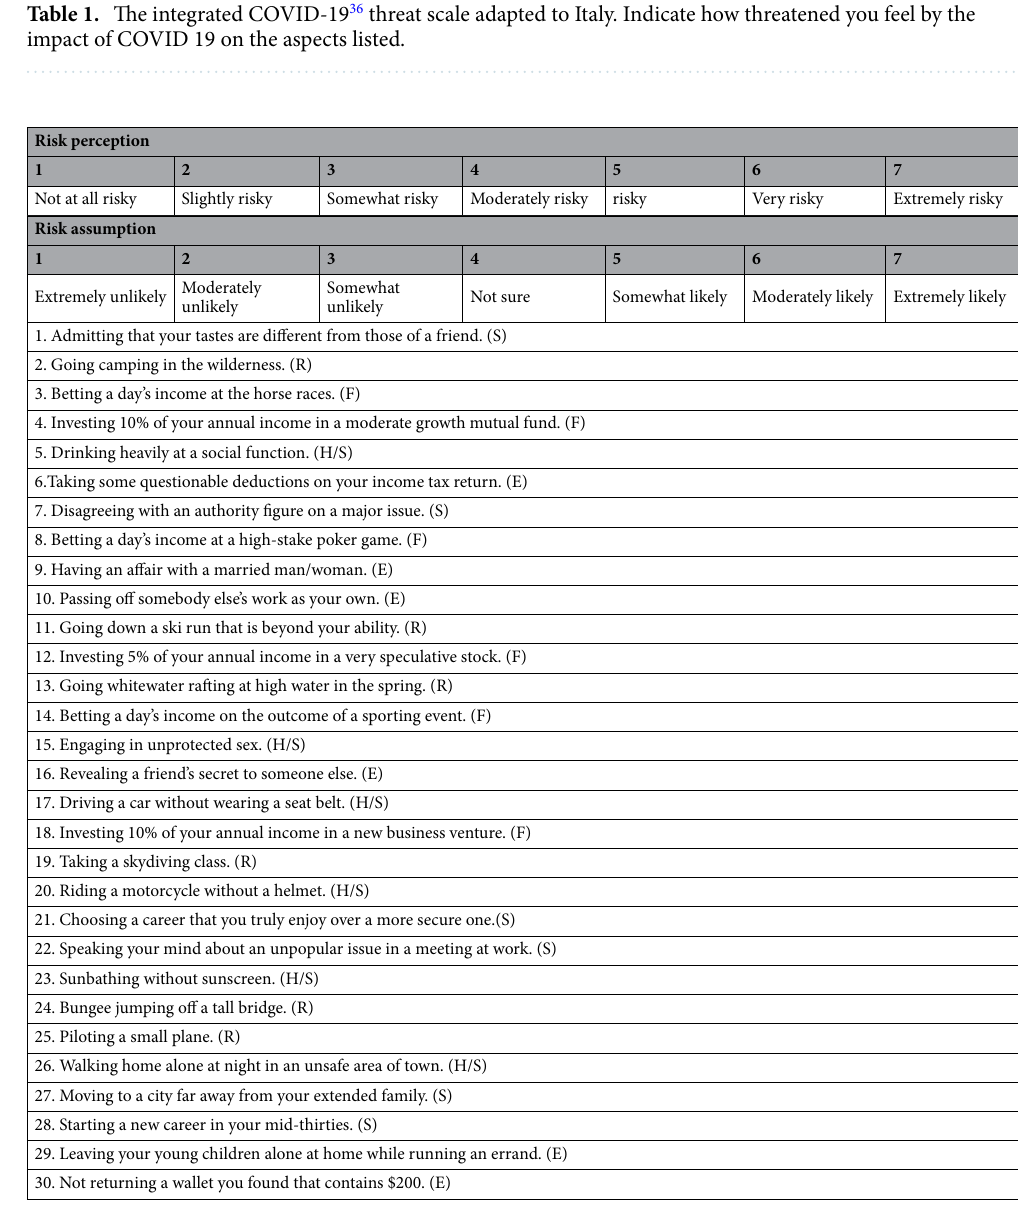
Table 2. The Domain-Specific Risk-Taking (DOSPERT) scale 39 . For each of the following statements, please indicate the likelihood that you would engage in the described activity or behavior if you were to find yourself in that situation. Provide a rating from Extremely Risky/Unlikely to Extremely Risky/Likely, using the above scale. E = Ethical, F = Financial, H/S = Health/Safety, R = Recreational, and S =